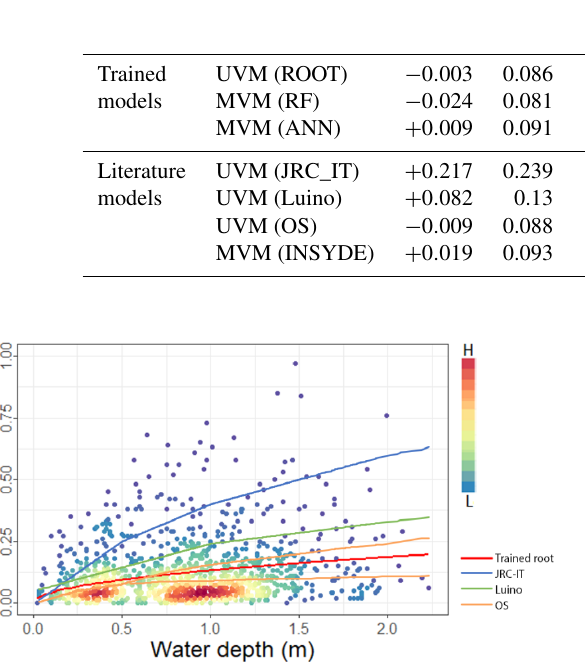
Figure 12. Scatter plot of relative damage records ( y axis) and wa- ter depth ( x axis). Point colours represent record densities. The red line shows the empirical root function ( y = 0 . 13 ( best suited. The other lines represent the three UV literature models (JRC-IT, Luino and OS) selected for the test. The OS model is made up of two curves in relation to the number of